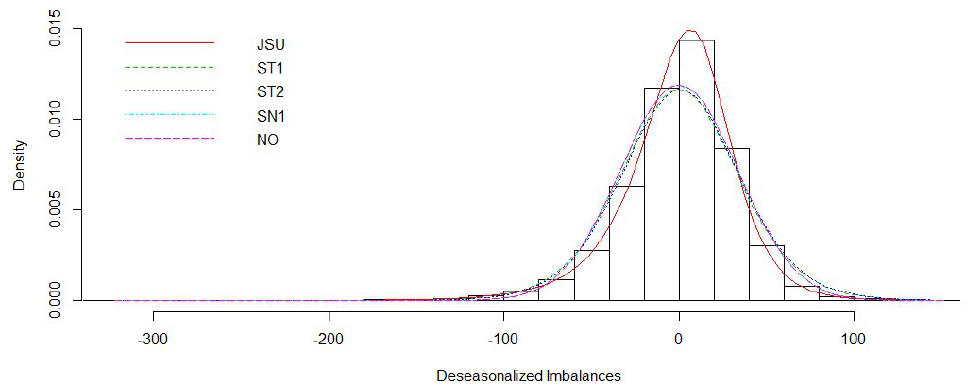
Figure 2. Comparisons of density fits for JSU, ST, SN and NO distributions.